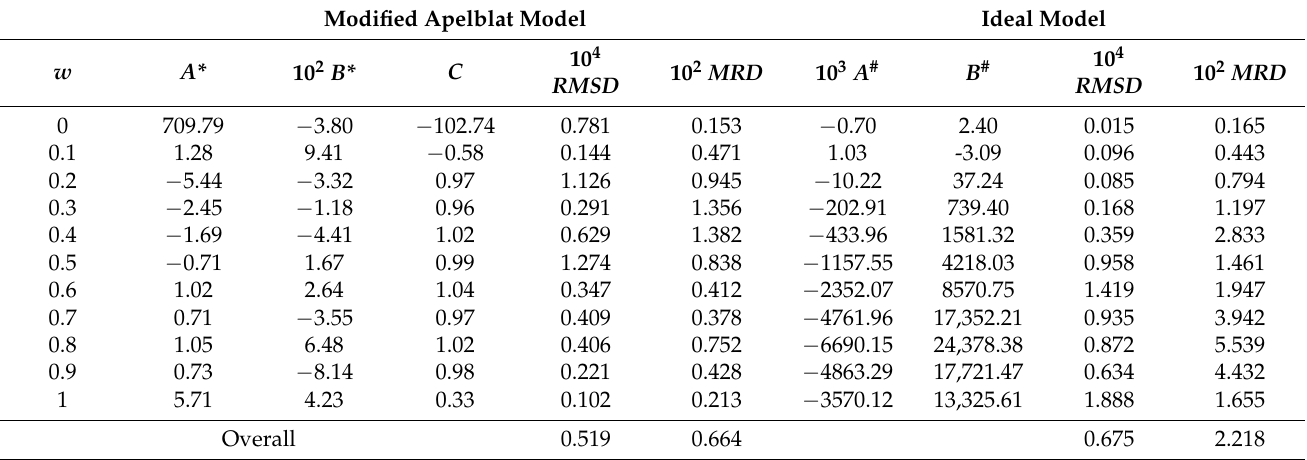
Figure 4. ( a ) Experimental mole fraction solubility ( X exp ) of GLN in a (1,4-dioxane + water) mixture at T = (293.15~323.15) K. ( b ) Optimization of mole fraction solubility of GLN vs T /K and mole fraction of 1,4-dioxane ( w ) in the (1,4-dioxane + water) mixture. The solubility of GLN in 1,4-dioxane + water mixture was evaluated using a modified AM model, ideal model (Table 6), CNIBS/R-K model, and JA model (Table 7). The parame- ters were evaluated and the deviations of modified AM ( RMSD 0.519, MRD 0.664), ideal model ( RMSD 0.675, MRD 2.218), CNIBS/R-K model ( RMSD 0.358, MRD 3.936), and JA model ( RMSD 0.689, MRD 4.247) were obtained, of which CNIBS/R-K model had smaller deviation and indicated a good agreement between the experimental and calculated data of GLN solubility in the 1,4-dioxane + water mixture (Tables 6 and 7). The modified AM model only considered the temperature, not the mole fraction of the co-solvent; therefore, the CNIBS/R-K model was considered optimal for the 1,4-dioxane + water mixture. Table 6. Parameters of the modified Apelblat equation and Ideal equation for GLN in a 1,4-dioxane ( w ) + water (1 − w )